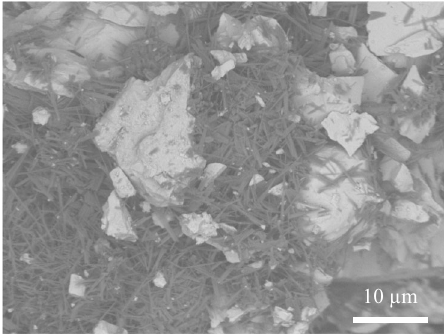
Fig. 7 The back scattering image of the surface of the zircon particle immersed in 0.1 M NaOH (aq). The scale bar is 10 μ m.